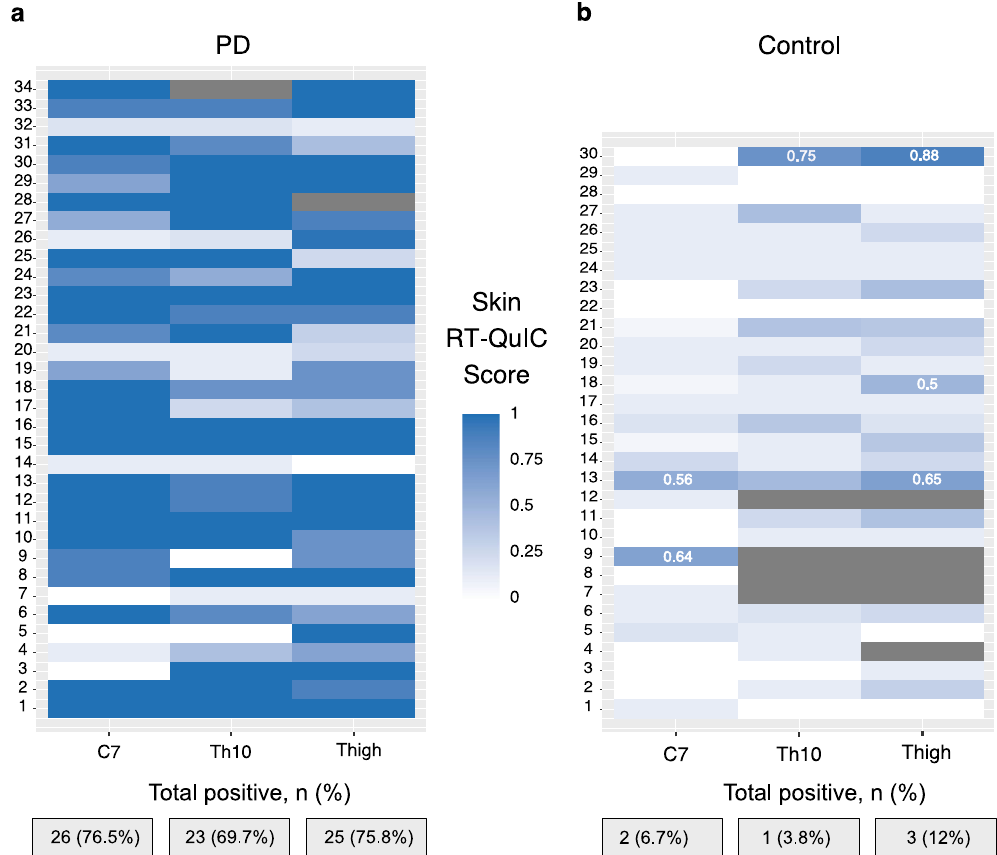
Fig. 3 α -syn seeding activity is conserved across multiple biopsy sites in PD and is universally low in controls. Distribution of skin RT-QuIC scores ranging from 0 (white) to 1 (blue) across cervical (C7), thoracal (Th10), and thigh sites in PD patients ( a ) and control subjects ( b ). The graphs show a mostly uniform presence of skin α -syn seeding activity in individual biopsy sites in PD patients, and only sparsely in single biopsy sites in controls. Subjects are listed vertically. The total number (%) of biopsies with positive RT-QuIC scores ( ≥ 0.5) at each site for the PD and control groups is indicated below each graph. Missing biopsy spots are shaded gray. Scores are pooled from both Cleveland and Würzburg